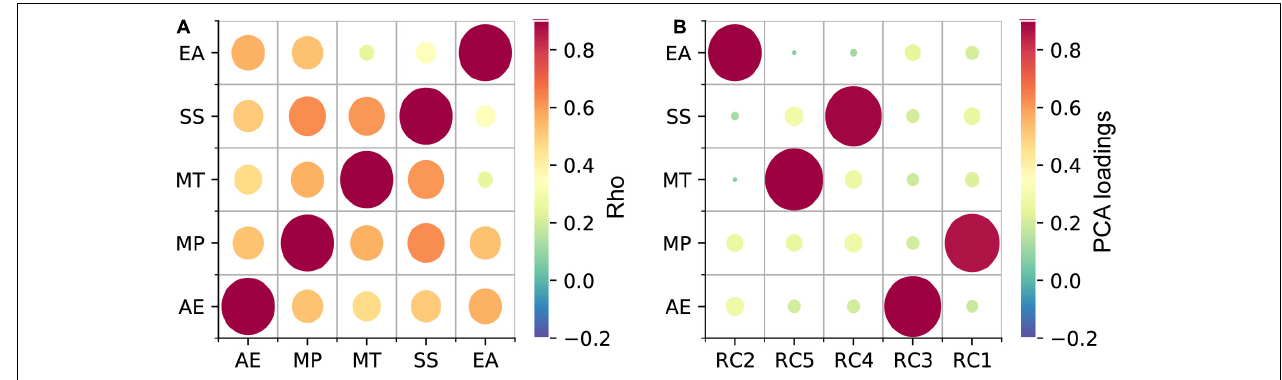
FIGURE 2 | Gold-MSI subscale scores were decorrelated using PCA. (A) Strong to moderate correlations between the scores of the Gold-MSI subscales were observed. (B) Load of the 5 PCA components on the Active Engagement (AE), Musical Perception (MP), Musical Training (MT) , Singing Skill (SS), and Emotional Attachment (EA) subscales of the Gold-MSI. The color and size of the circles indicate the coefficient (rho) of the Spearman correlation and the loading strength in panels A and B, respectively (see scale).